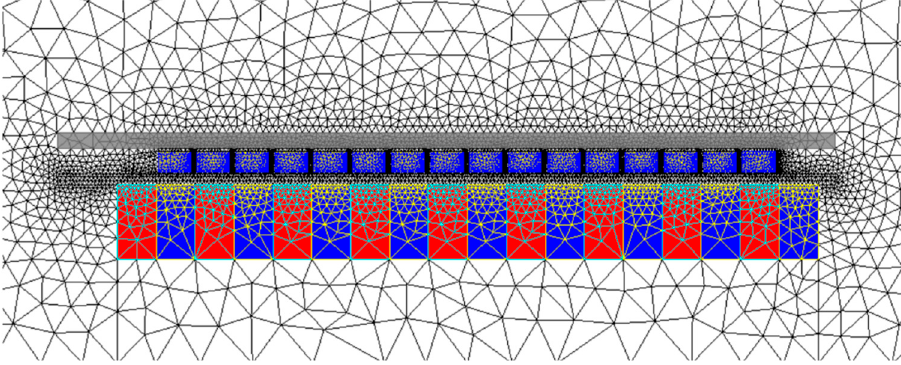
Figure 5. Surface mesh elements in the 2D FEA analysis.